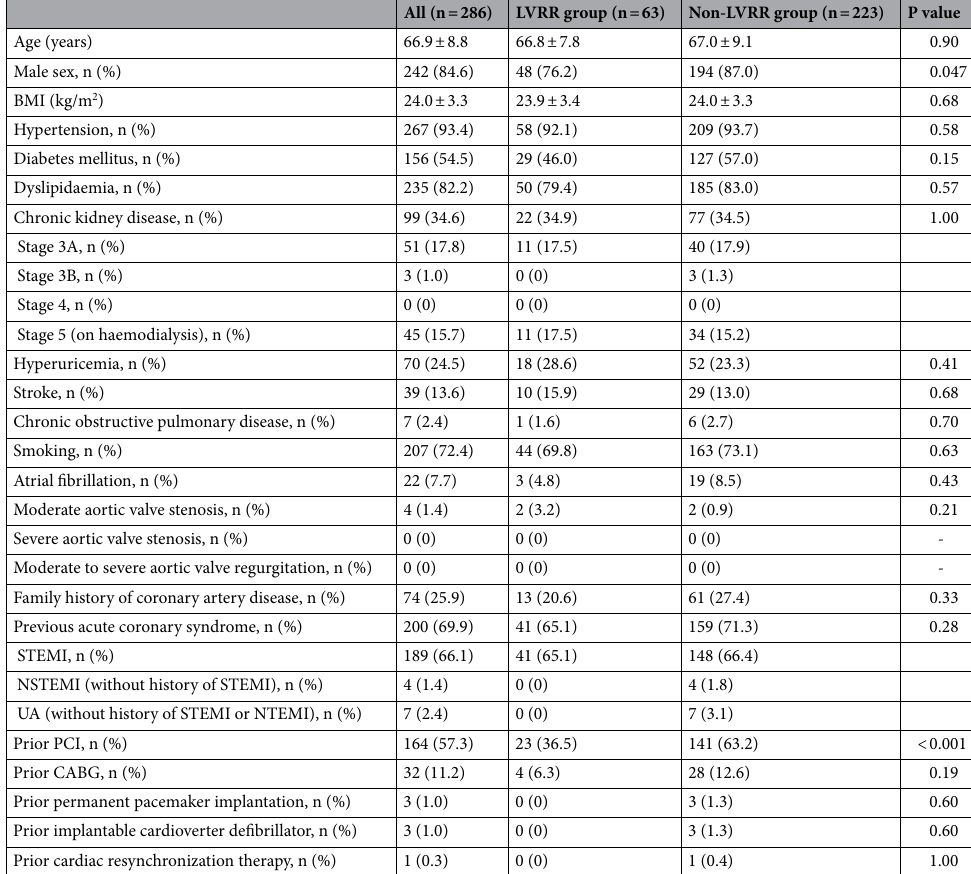
non-ST-elevation myocardial infarction; UA unstable angina; PCI percutaneous coronary intervention; CABG coronary artery bypass